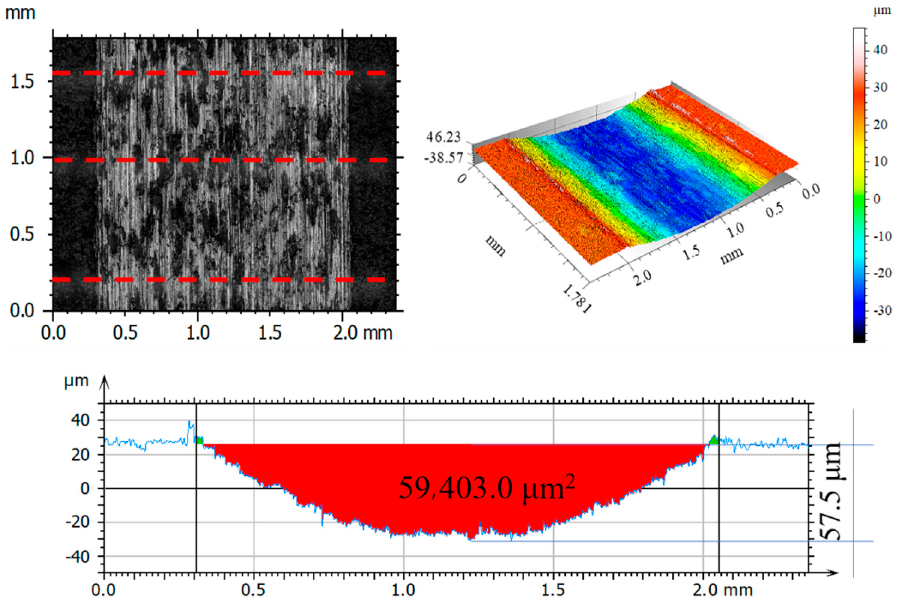
Figure 13. Optical and axonometric views of sample wear track and the wear profile on transverse cross-section after the dry sliding of the oxygen ion-implanted steel 316L—Al 2 O 3 friction pair.